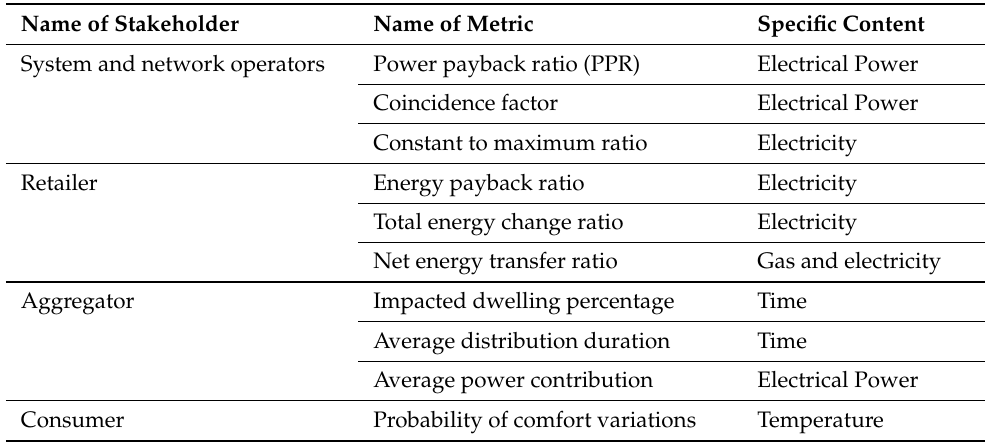
Table 8. Metrics for power system